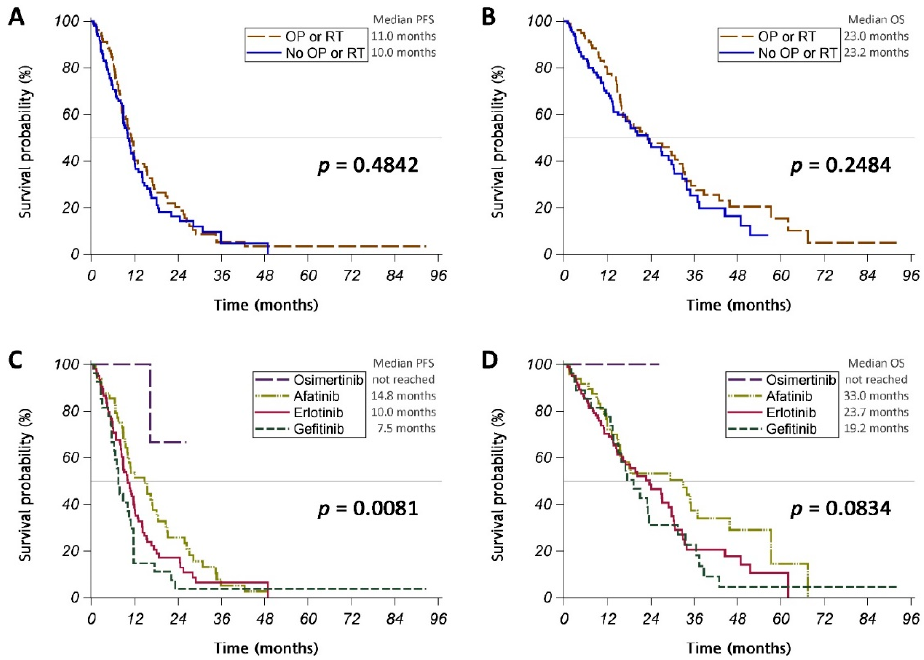
Figure 2. ( A , C ) Progression-free survival (PFS) and ( B , D ) overall survival (OS) of patients classified according to ( A , B ) those undergoing or not undergoing surgery (OP) or radiotherapy (RT) for brain tumor or ( C , D ) those receiving different epidermal growth factor receptor tyrosine kinase inhibitors.